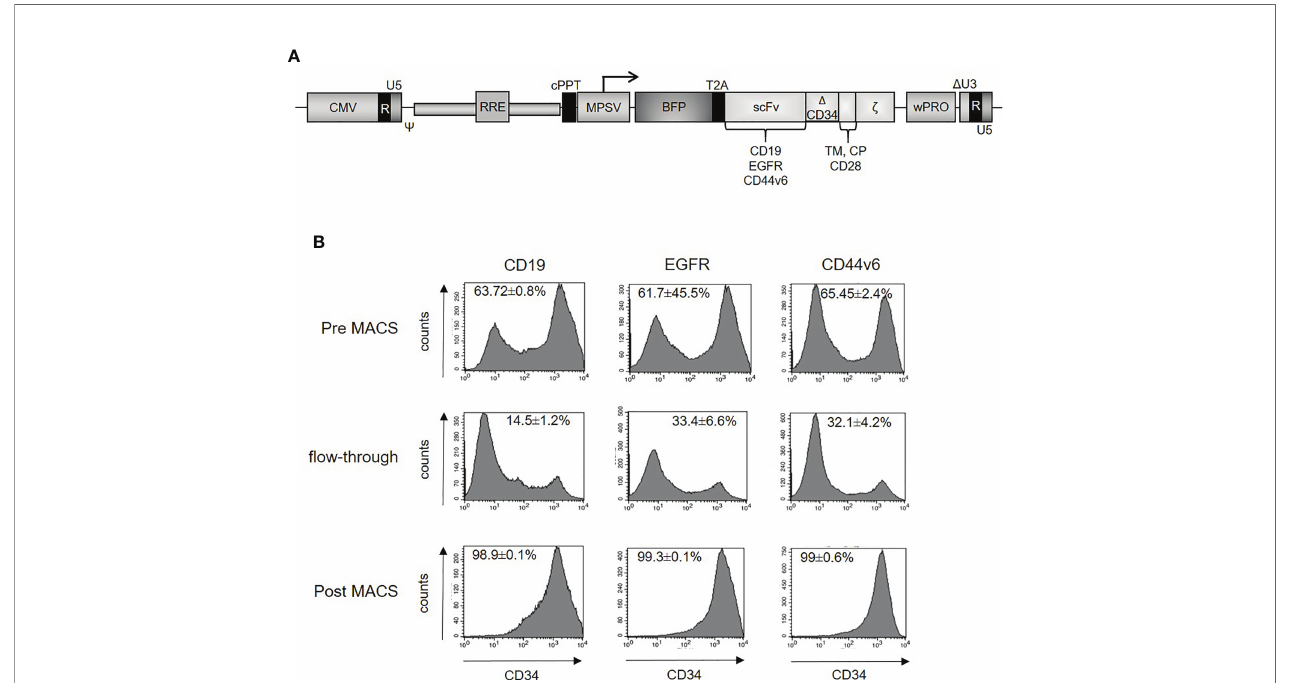
FIGURE 2 | (A) Schematic design of the lentiviral vector for expression of the second-generation CARs. The constructs contain CD19, EGFR or CD44v6 scFv, CD34 hinge domain, CD28 transmembrane and intracellular domain, CD3 z cytosolic domain and blue fl uorescent protein (BFP). (B) Enrichment of CAR-positive T-cells. Primary human T-cells were lentivirally transduced with constructs expressing CD19, EGFR, or CD44v6 CARs. Three days after transduction, CAR-positive T-cells were stained with CD34 microbeads (Miltenyi) and fi nally enriched by magnetic cell sorting. Different fractions (pre, fl ow-through, post MACS) were analyzed by fl ow cytometry using the QBEND-PE antibody ( Supplementary Table S1 ). CAR expression (x-axis) is plotted against the absolute cell count (y-axis). Illustrations were gated with the percentage of positive cells. Data are depicted as mean ± SEM for three different